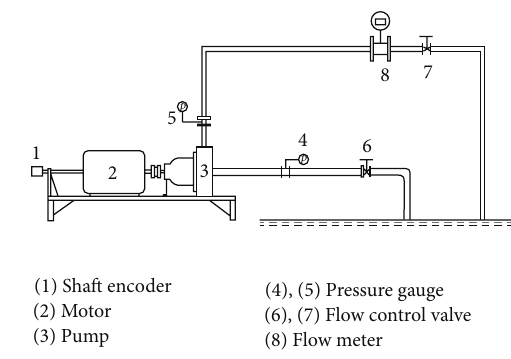
Figure 2: Sketch of the open test rig.